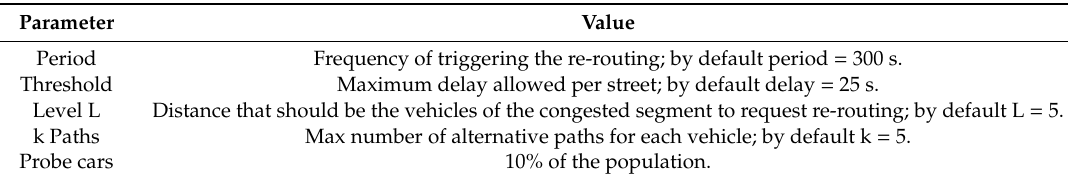
Table 2. Parameters used in the evaluation